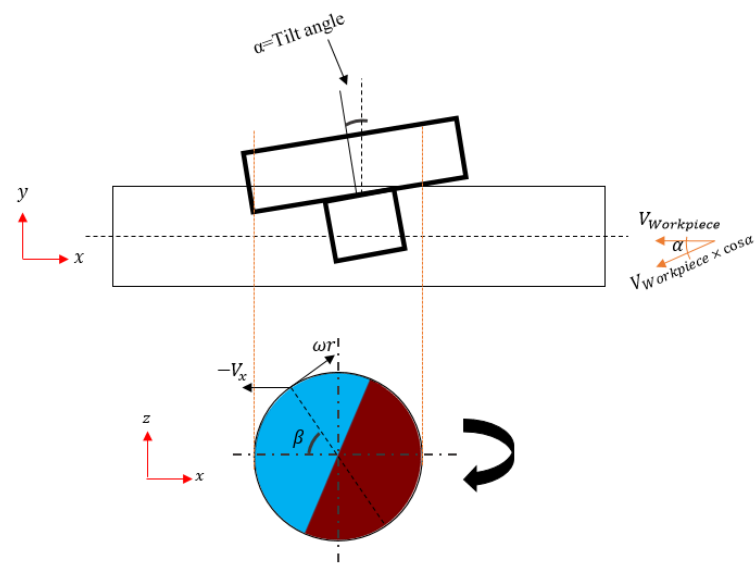
Figure 6. Rotation of the contact area.